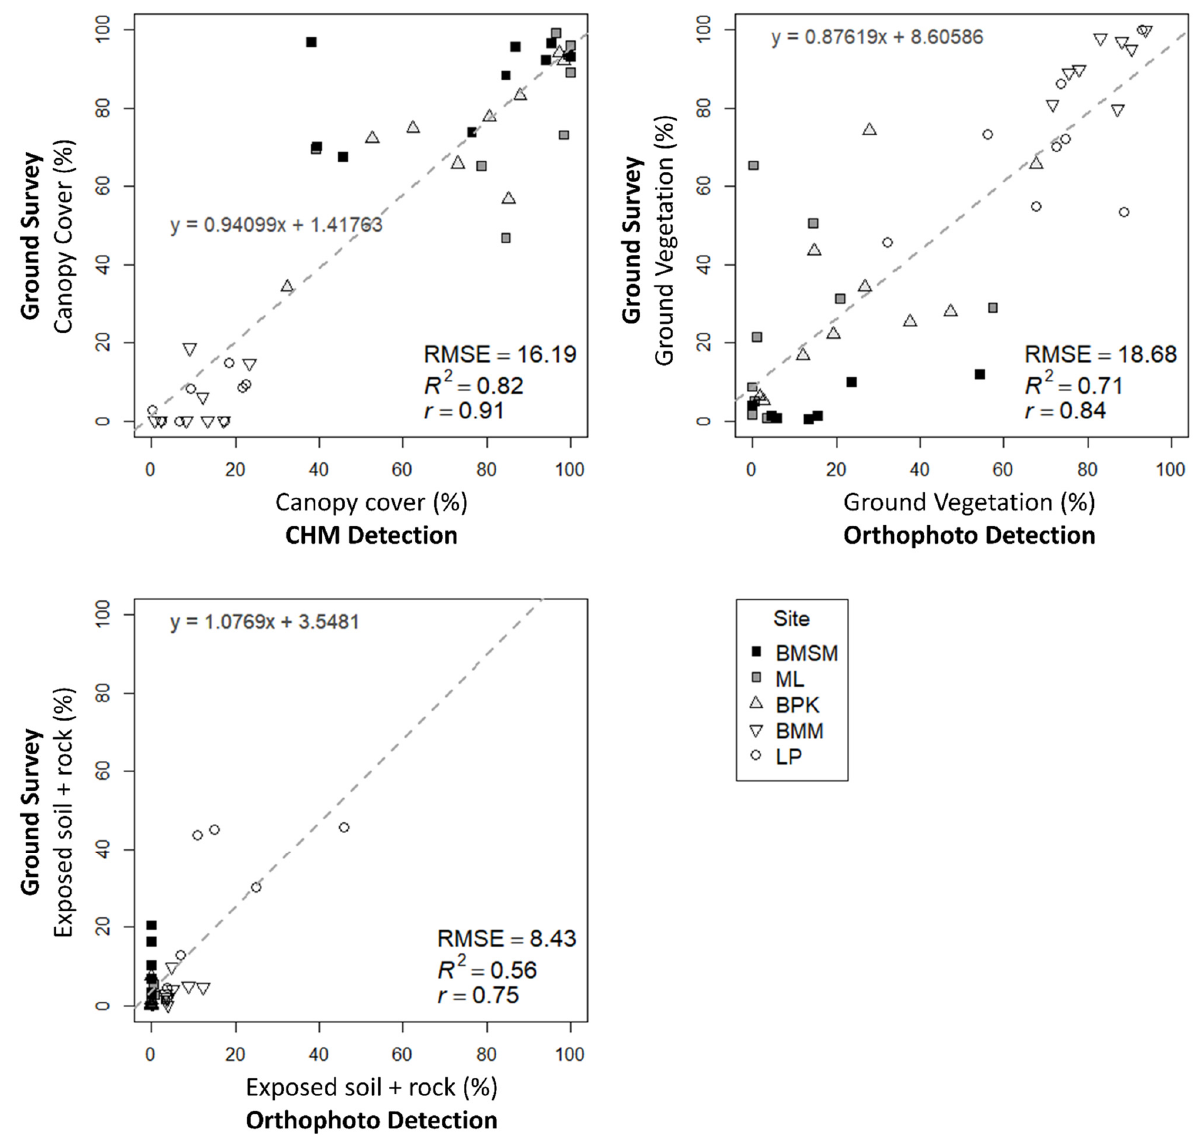
Figure 9. Scatter plots of the percent of three ground-elements. ( Left ) Percent canopy cover. ( Right ) Percent ground vegetation. ( Lower ) Percent exposed soil + rock. (CHM): Canopy-height model; (RMSE): Root mean square error; ( r ): Pearson’s correlation coefficient. Tree height variables, derived from the CHM, were weakly correlated with the same measured in ground surveys (max, mean, and median tree height in each circular sample plot) (Figure 10). Highest correlation between drone-derived and ground data was achieved for max tree height ( R 2 = 0.51). Mean tree height reduced the influence of outliers, despite the weak correlation ( R 2 = 0.31), and was a better measure than median tree height ( R 2 = 0.23). Furthermore, RMSE of mean height was lower (3.3 m) than for maximum (4.1 m) and median (3.5 m) height.